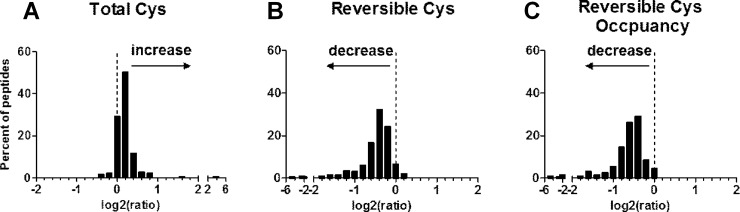
Global changes in cysteine oxidation associated with catalase overexpression.Log2 transformed reporter ion rations from Cat Tg vs. WT mice were used to generate frequency histograms of TMT-tagged peptides. The ratios used are as follows: (A) changes in the total available cysteines; (B) changes in the reversibly oxidized cysteine thiols; (C) changes in the thiol occupancy of reversible oxidation (dashed line indicates no change with log2 ratio = 0).